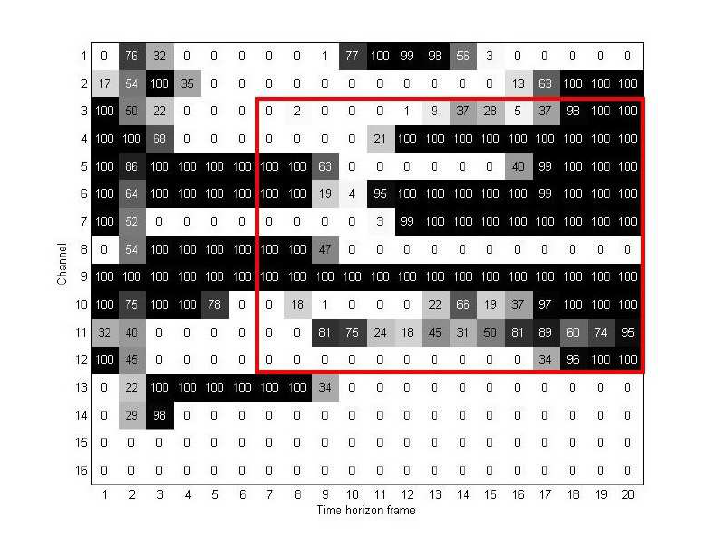
Figure 8. Discriminant information map U D with region selection using window W .